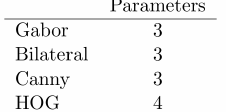
Table 1. The number of parameters of